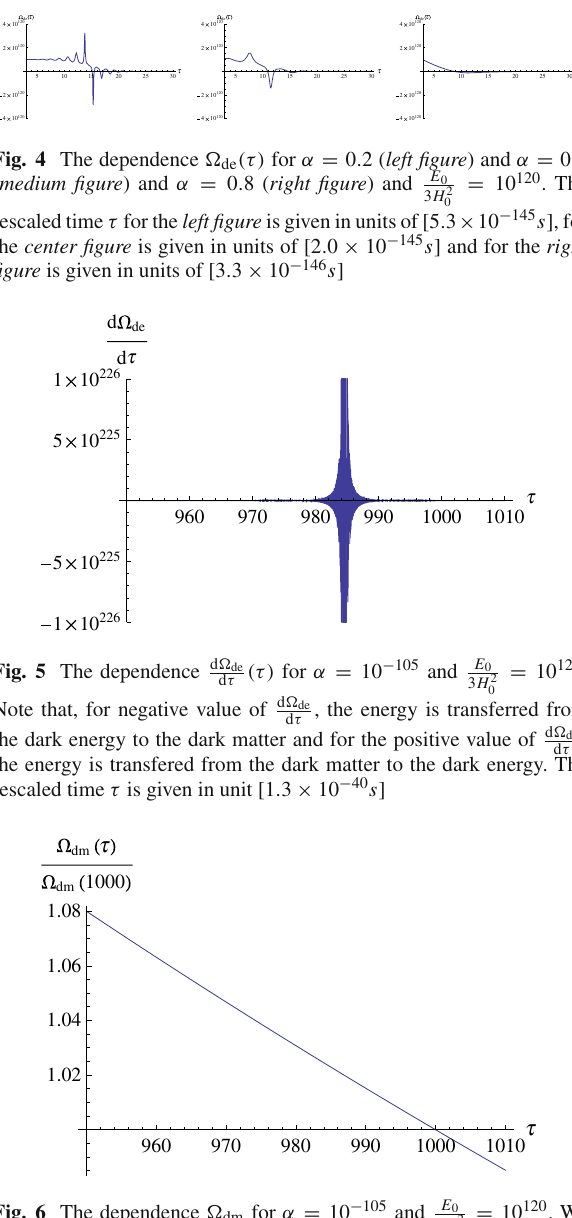
960 = 10 120 . We Fig. 6 The dependence (cid:5) dm for α = 10 − 105 and E 0 3 H 2 0 include the influence of the radiation for the evolution of the matter. Note that the dark energy has a negligible influence on the evolution of the matter. The rescaled time τ is given in units of [ 1 . 3 × 10 − 40 s